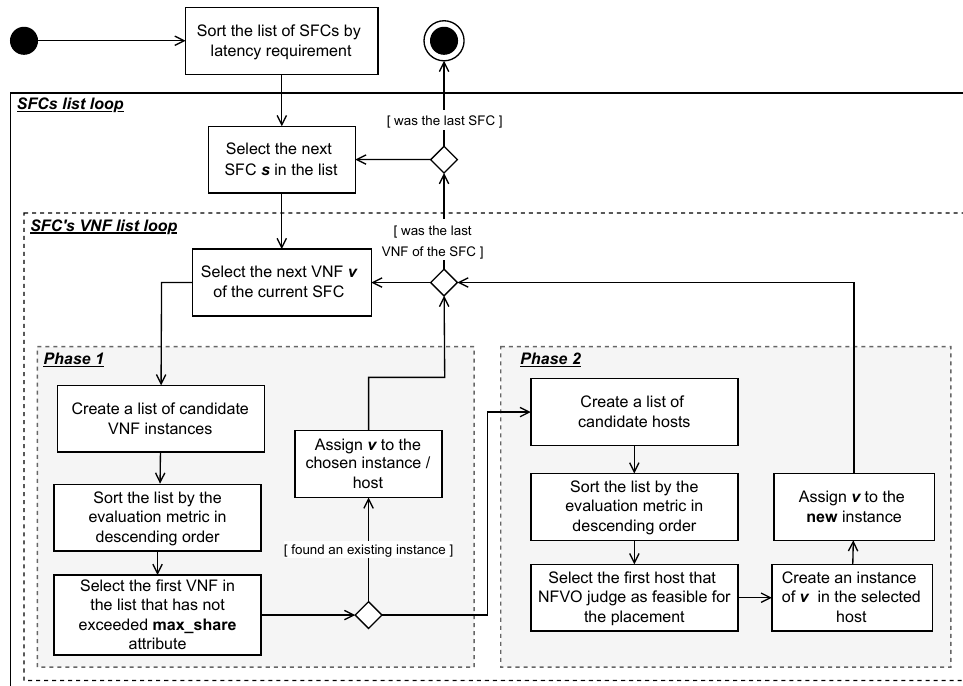
Figure 1. Smart VNF placement